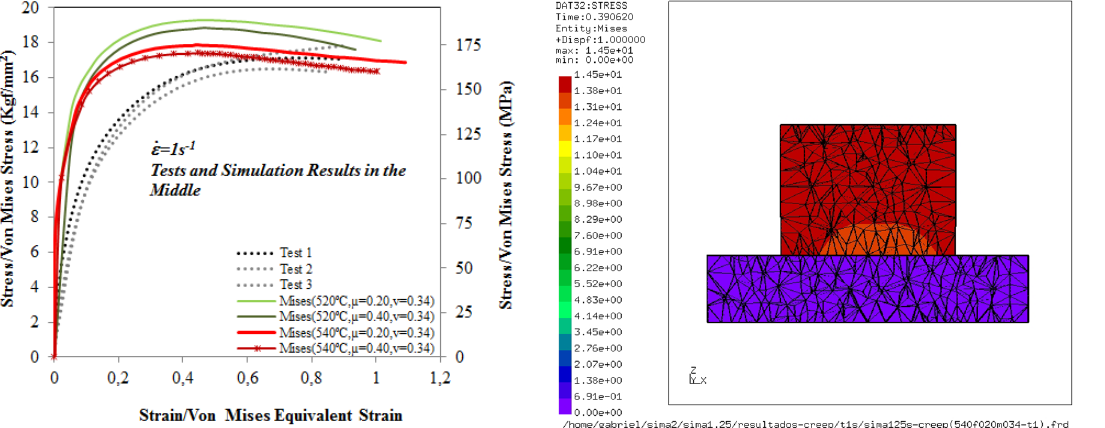
Figure 9. Cut view of Von Mises stress [Kgf/mm 2 ] for a copper at 540 °C, tested under compression with a strain rate of 1s -1 , with a friction coefficient of 0.20, and a Poisson´s ratio of 0.34, at 0.39